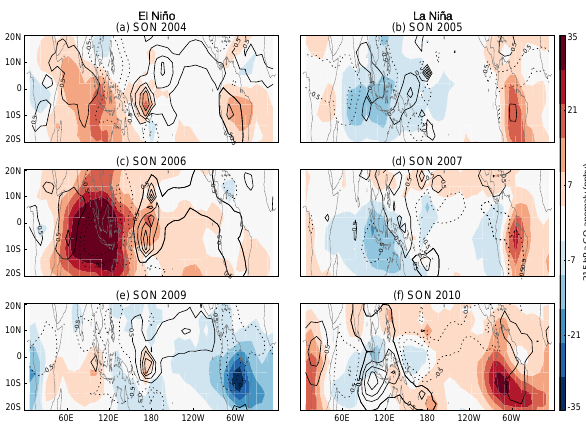
Fig. 7. As in Fig. 6, but for surface CO emission (shaded contour) and precipitation (line contour) anomalies. The precipitation con- tour interval is 4mmd − 1 . The solid line represents positive precipi- tation anomaly, and the dotted line represents negative precipitation